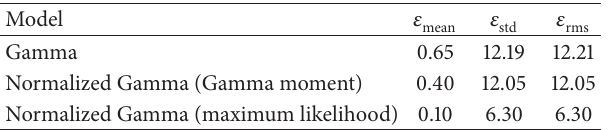
𝜀 𝜀 mean std rms